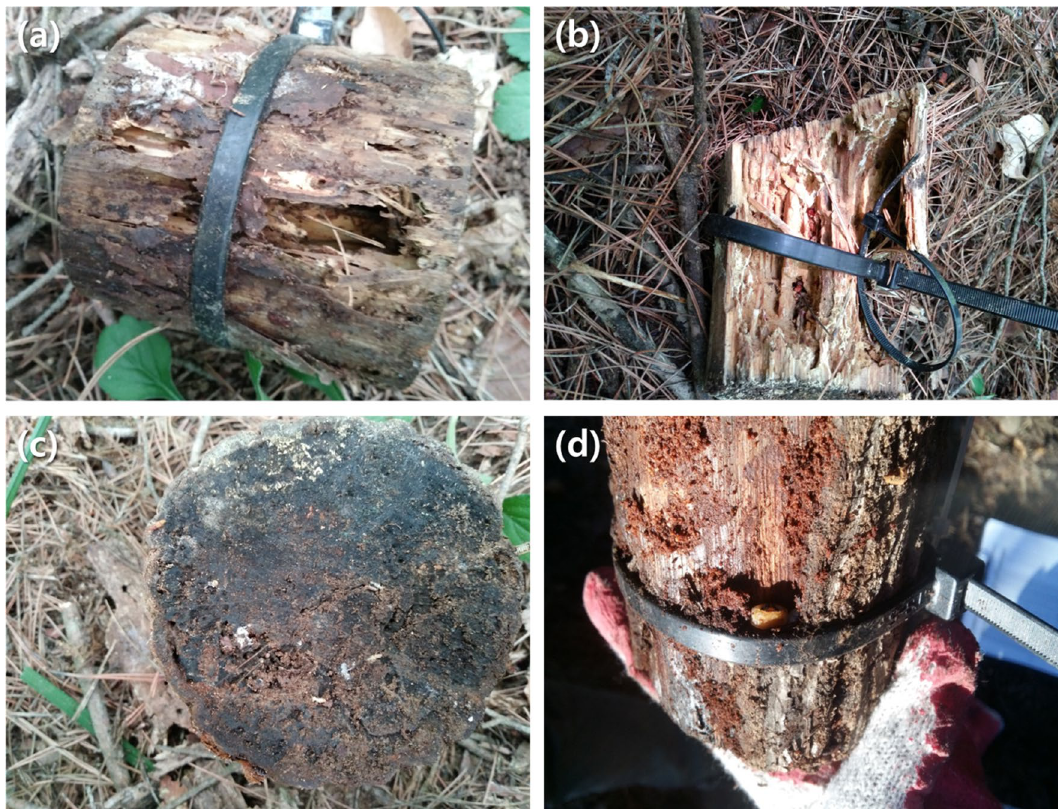
Figure 3. Photographs of decomposer invertebrates on deadwood samples. Feeding damages by subterranean termites on pine ( a , b ) and oak ( c ) samples, and incidence of beetle larvae ( d ) after 24 months (photograph by Seongjun Kim).